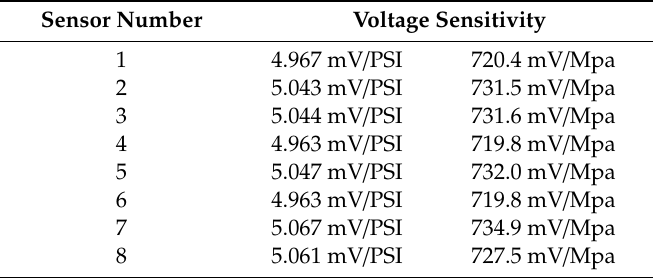
Table 2. Sensitivity of pressure sensors.